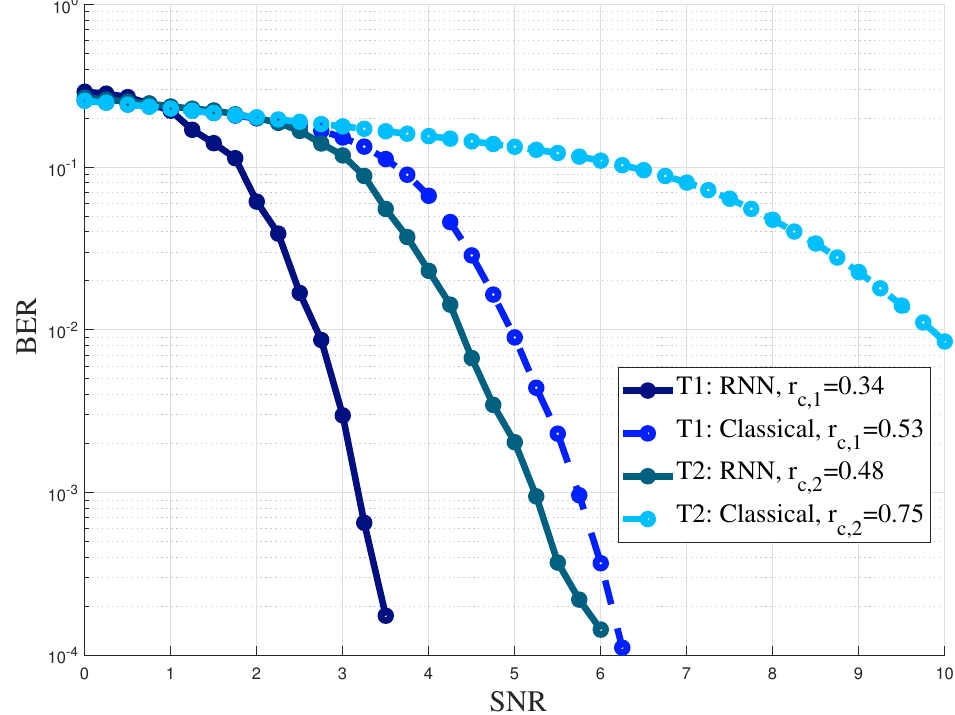
Figure 3. LPLT (ISD = 15 km). Performances of the RNN vs. classical Terrestrial Broadcasting system with two throughputs (T1 = 114 kbit/s, T2 = 162 kbit/s) and a fixed speed of 160 km/h.